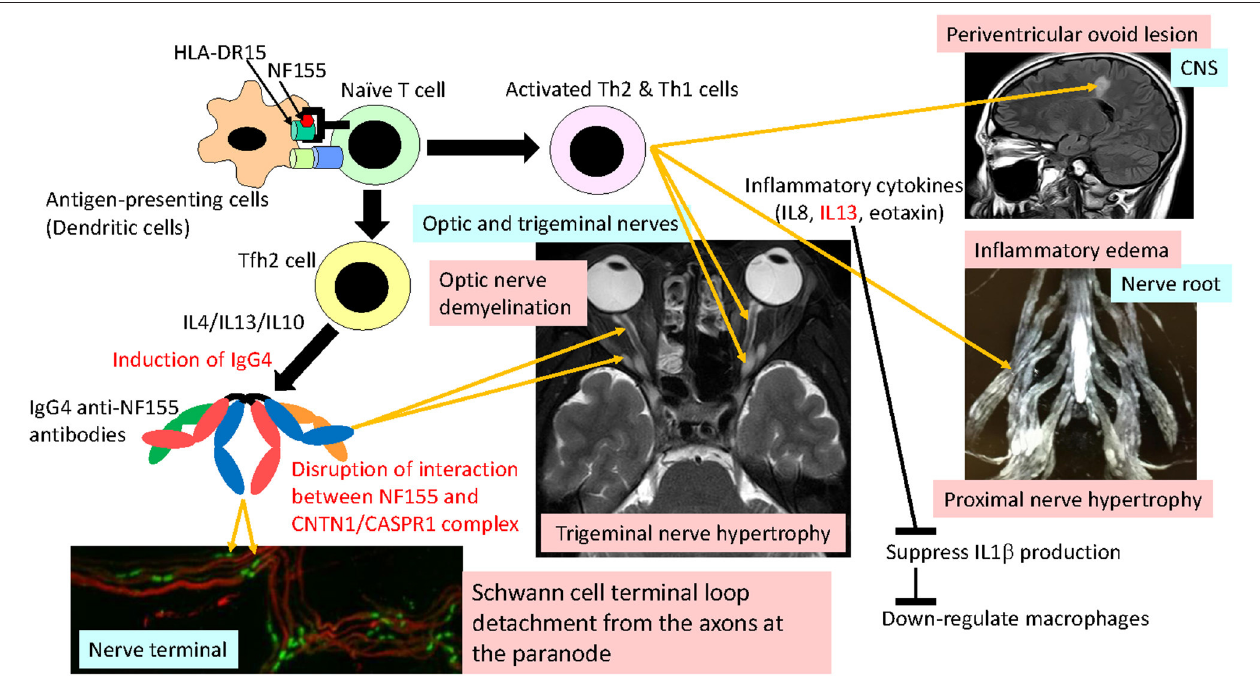
FIGURE 4 | Hypothetical mechanism of NF155 + chronic inflammatory demyelinating polyneuropathy (CIDP)/combined central and peripheral demyelination (CCPD). NF155 peptides are presented by a DRB1*15:01/DRB1*15:02 and/or DQA1*01:02-DQB1*06:02/DQA1*01:03-DQB1*06:01 complex to naive T cells, initiating Tfh2/Th1 cell differentiation. Tfh2 cells produce IL4/IL13/IL10, which induce IgG4 class switching. IgG4 anti-NF155 antibodies invade the nerve terminal and nerve roots where the blood nerve barrier is absent or leaky. Invaded anti-NF155 antibodies disrupt the interaction between NF155 and the CNTN-1/CASPR1 complex at the paranode, which leads to Schwann cell terminal loop detachment from axons. Activated Th2 and Th1 cells cause inflammation at the spinal roots, resulting in nerve root hypertrophy, occasionally producing periventricular ovoid lesions in the central nervous system (CNS). Overproduction of IL13 downregulates IL1